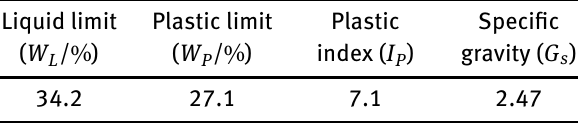
Table 5: Physical and water physical characteristic of fly